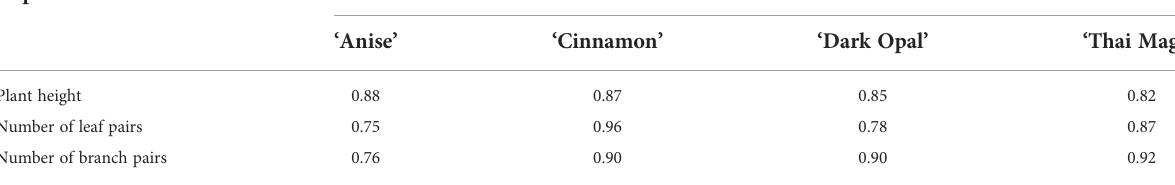
TABLE 7 Correlation between basils ’ complex VOC pro fi les and their morphological